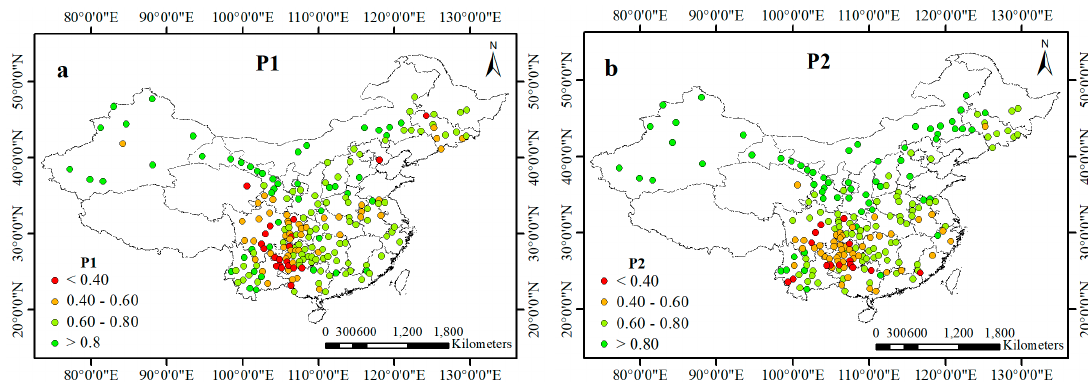
Figure 10. Percentage of consistent ( a ) all drought events and ( b ) severe and extreme drought events between the SWDI-SMAP and AWD at 204 monitoring stations with both SM and climate data. 30 pairs of 7-day averaged data were used from 1 April 2016 to 30 September 2016.